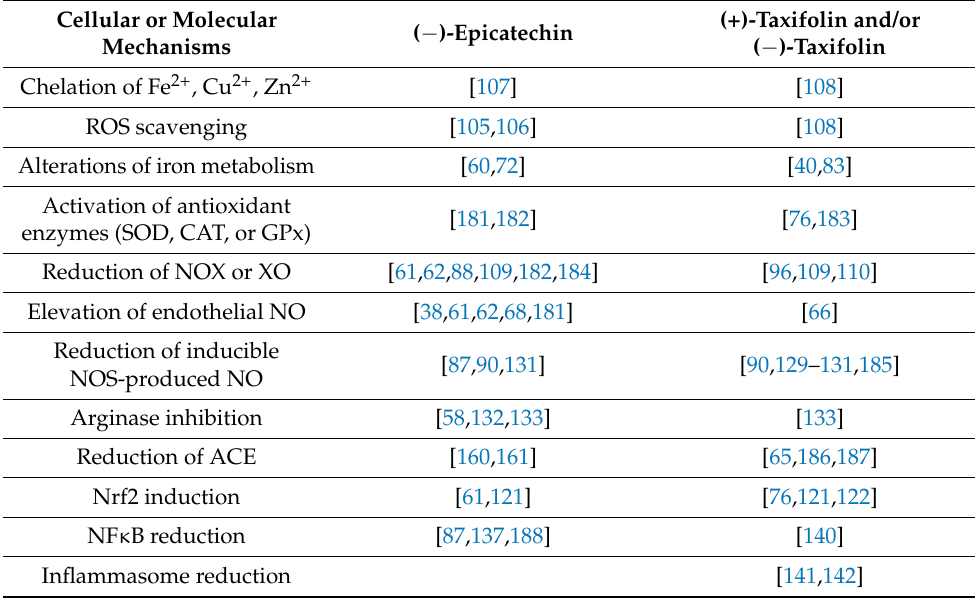
Table 2. Summary of cellular or molecular mechanisms underlying the biological effects of ( − )- epicatechin as well as (+)-taxifolin and/or ( − )-taxifolin. Cellular or